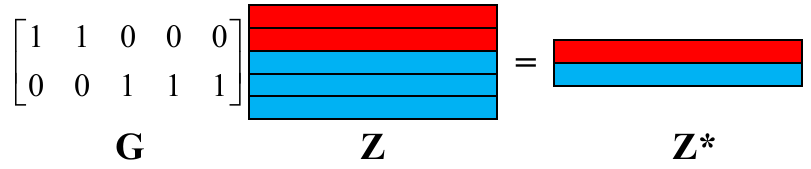
Figure 2. The class domain and the endmember domain for the sub-pixel abundance map. Z ∈ (cid:60) q × v is the sub-pixel abundance map in endmember domain with two classes (labelled as red and blue) and five endmember spectra and Z* ∈ (cid:60) p × v is the sub-pixel abundance map in the class domain with two classes. G ∈ (cid:60) p × q is a grouping matrix to transform Z into Z* .